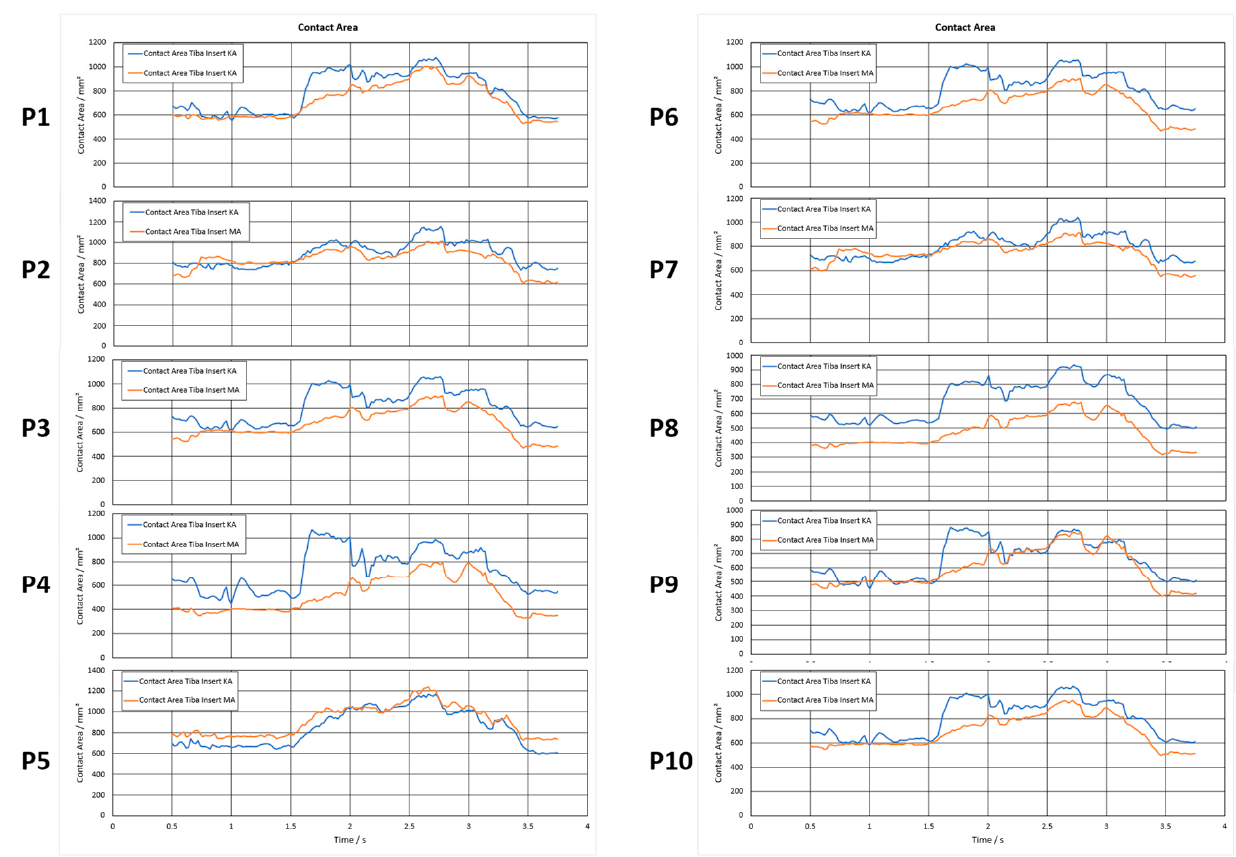
Figure 4. Contact area evolution in mm² of the tibia inserts over one gait cycle.